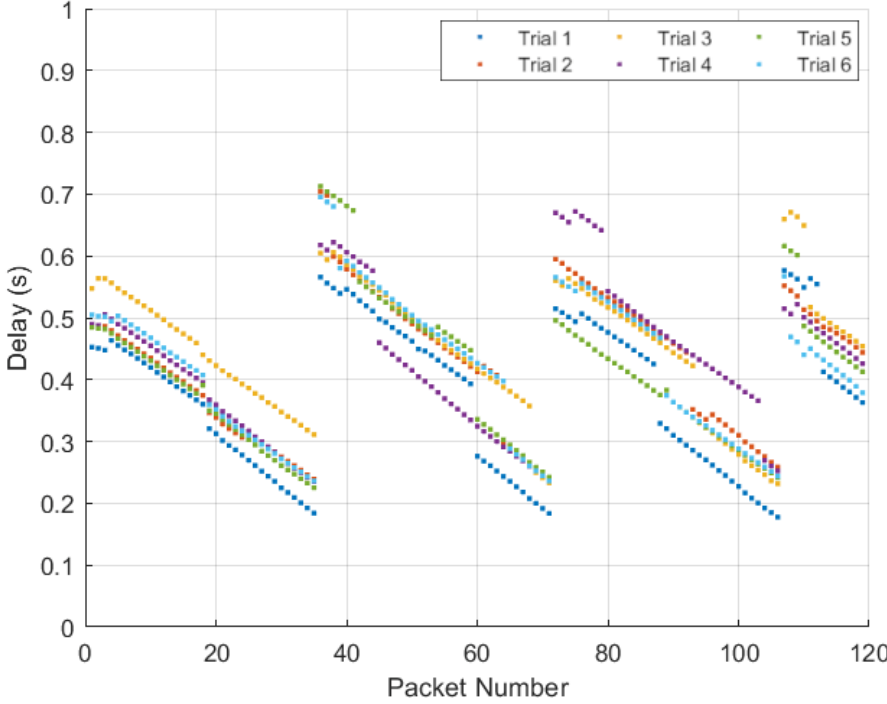
Figure 27. Delay in seconds over the IEEE 802.11p connection from the transmitting HackRF to the receiving HackRF for the 120 packets transmitted over six